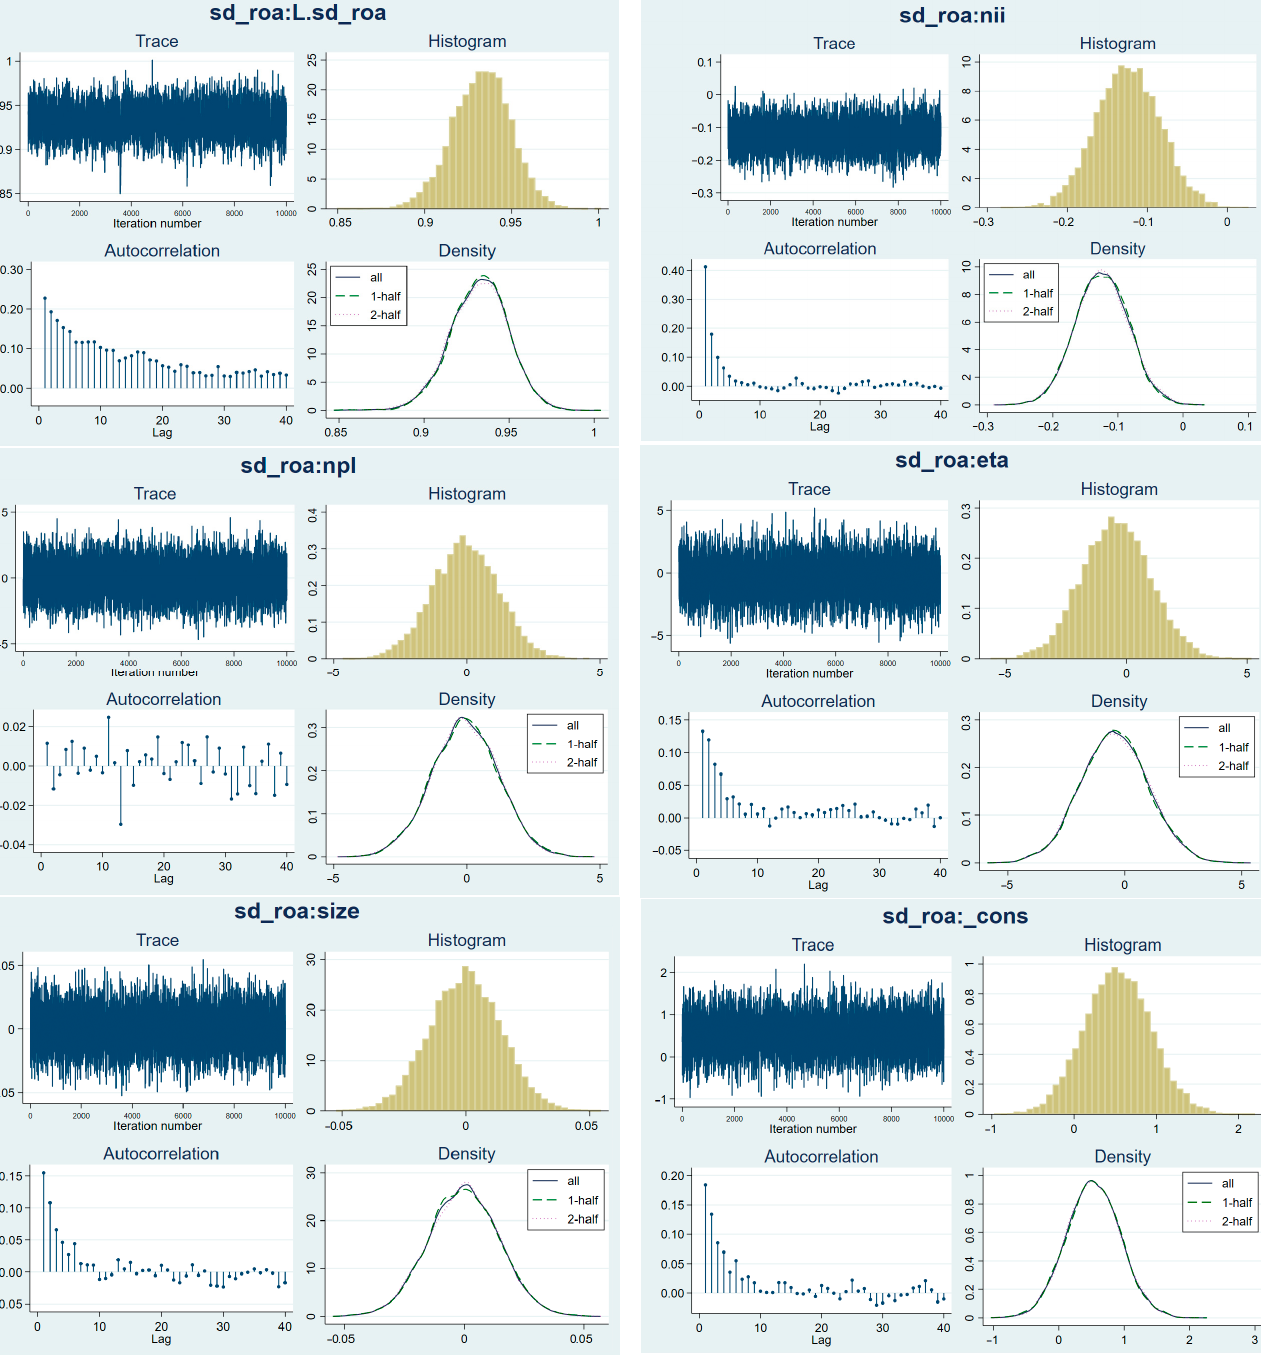
Figure 2. Results of testing the convergence of MCMCs in the model with SD_ROA as dependent variable.